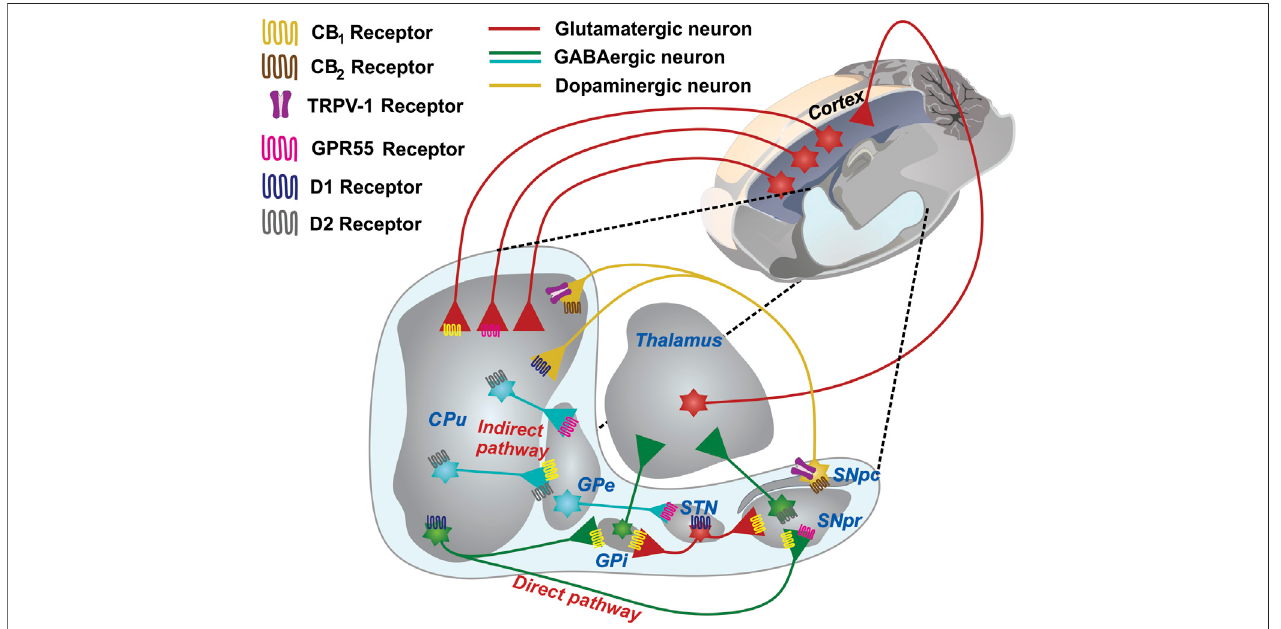
FIGURE 4 | The basal ganglia network and its wide expression of receptors in presynaptic neurons. A schematic representing the GABAergic and glutamatergic connections in a sagittal section of the rat brain is shown. The CPu, the main input nucleus of the circuit, receives cortical projections of glutamatergic neurons. The expression of D1 receptors in the striatum forms the direct pathway of the BG circuit, which is projected toward the GPi and SNpr. The expression of the D2 receptors forms the indirect pathway, which is projected toward the GPe and subsequently toward the STN, which then sends projections to the GPi and SNpr. The projections that emerge from the exit nuclei direct the thalamus and return the processed information to the cerebral cortex. The expression of CB1 receptors mostly occurs in both GABAergic and glutamatergic neurons. GPR55 is present in the GPe, CPu, STN, and SNpc. CB2 and TRPV-1 are the sole in terminals of the SNpc. Abbreviations: CPu, Striatum or caudate-putamen; GPi, Internal globus pallidus ; SNpr, Substantia nigra pars reticulata ; SNpc, Substantia nigra pars compacta ; GPe, External globus pallidus ; STN, subthalamic